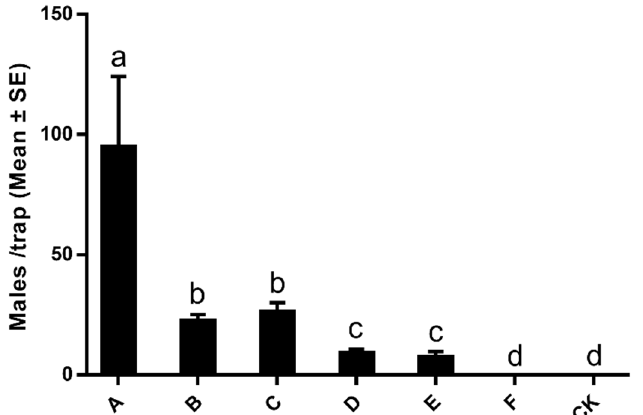
Figure 5. Numbers of Archips strojny male moths caught in traps baited with different ratios of syn- thetic sex pheromone components during a field trapping assay conducted at Longwu in Hangzhou City, Zhejiang Province, China (15 March 15–2 April 2021). A–F indicate different ratios of (Z)-11-tetradecenyl alcohol (Z11-14:OH) to (Z)-11-tetradecenyl acetate (Z11-14:Ac): (A) 0:100, (B) 5:95, (C) 10:90, (D) 20:80, (E) 40:60, and (F) 100: 0. CK indicates traps baited with only 100 µ L of n-hexane. Four replicates were used for each ratio. Different letters above the bars indicate significant differences ( p < 0.05, one-way ANOVA analysis followed by a Tukey’s post hoc test ( F = 90.235; df = 6,21)).